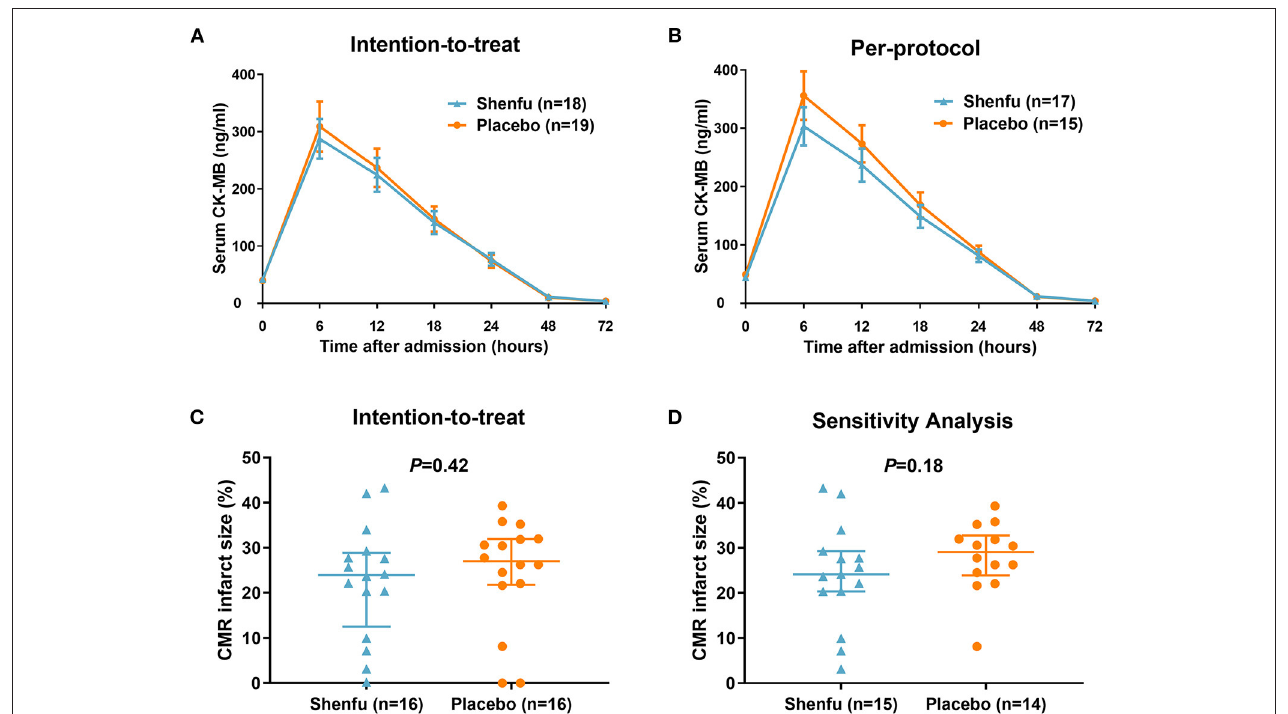
FIGURE 1 | Primary outcomes by treatment assignment. (A) Intention-to-treat and (B) per-protocol analysis of infarct size by CK-MB area under the curve over 72h post percutaneous coronary intervention, excluding patients with insufficient CK-MB values. (C) Intention-to-treat and (D) per-protocol analysis (sensitivity analysis by excluding patients with < 1% infarct size) of CMR Imaging infarct size (relative to left ventricular mass) 4 ± 1 days following percutaneous coronary intervention. CK-MB, creatine kinase-myocardial band; CMR Imaging, cardiac magnetic resonance